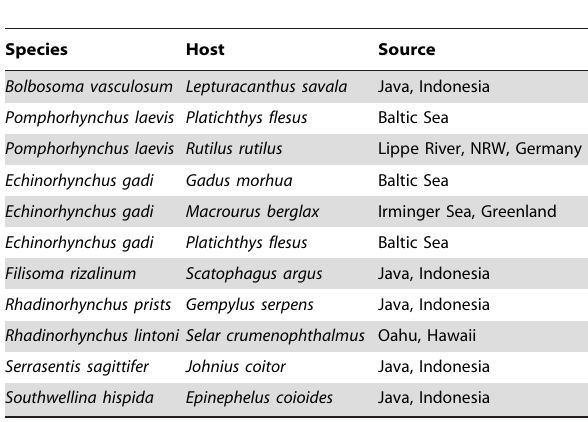
Table 1. Newly collected